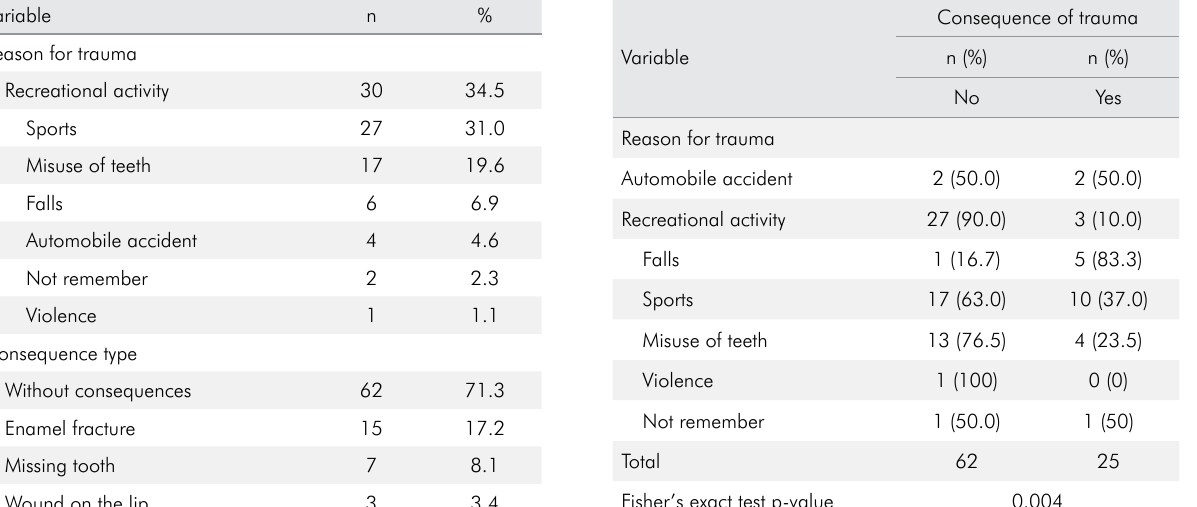
Table 2. Analysis of the distribution of schoolchildren by the reason for trauma and the consequences of the trauma.